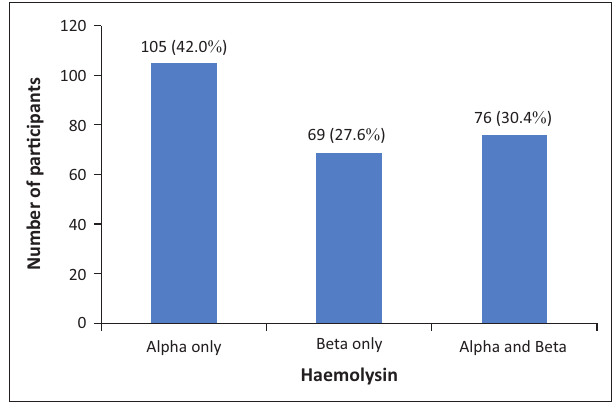
FIGURE 2: The prevalence of alpha and beta haemolysins among haemolysin- positive blood group O donors at the RHBBB, Cameroon, June 2020 –